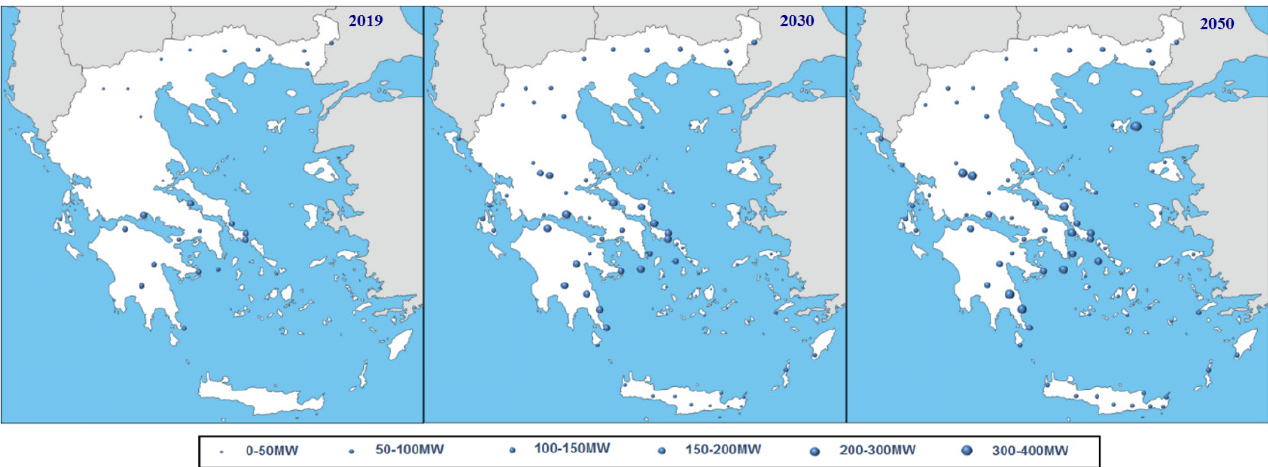
Figure 4. Location of wind farms by 2019, 2030 and 2050.